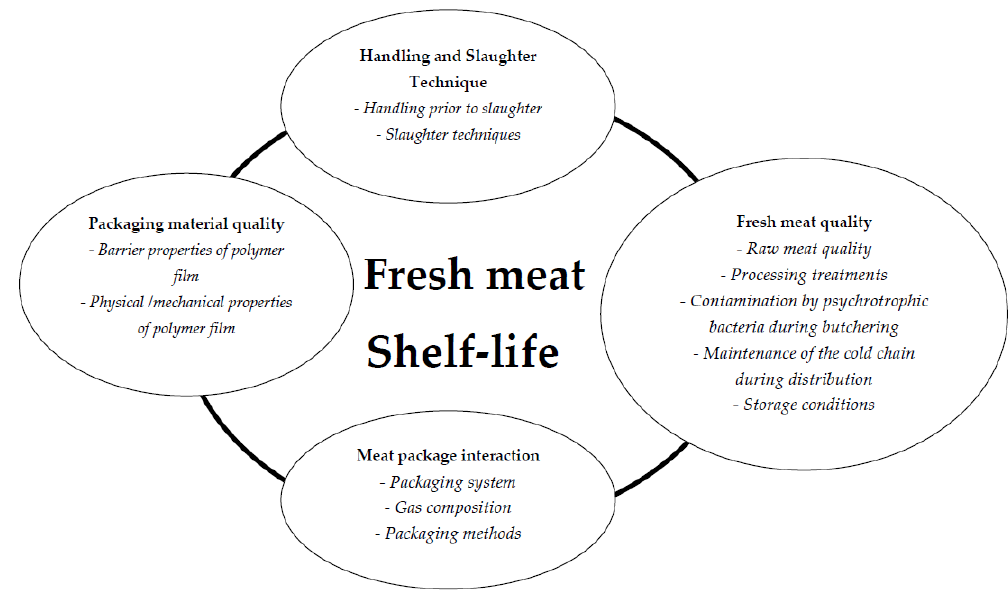
Figure 2. Factors influencing shelf-life of fresh meat.